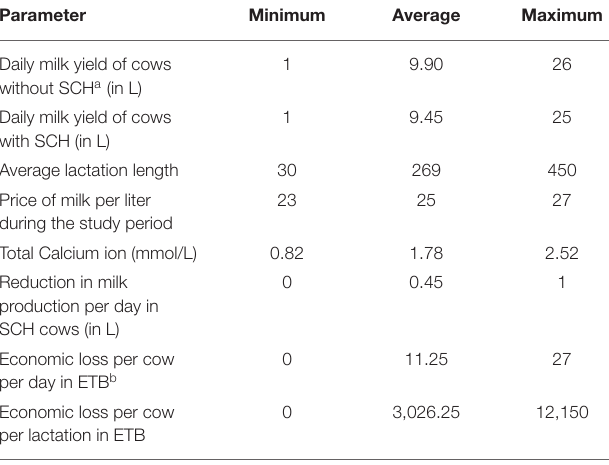
TABLE 5 | Descriptive statistics of model input parameters and economic loss associated with subclinical hypocalcemia based on half-a-day milk yield measured on 8 days in 47 Holstein Friesian × Zebu crossbreed lactating cows on 12 dairy farms in North-West